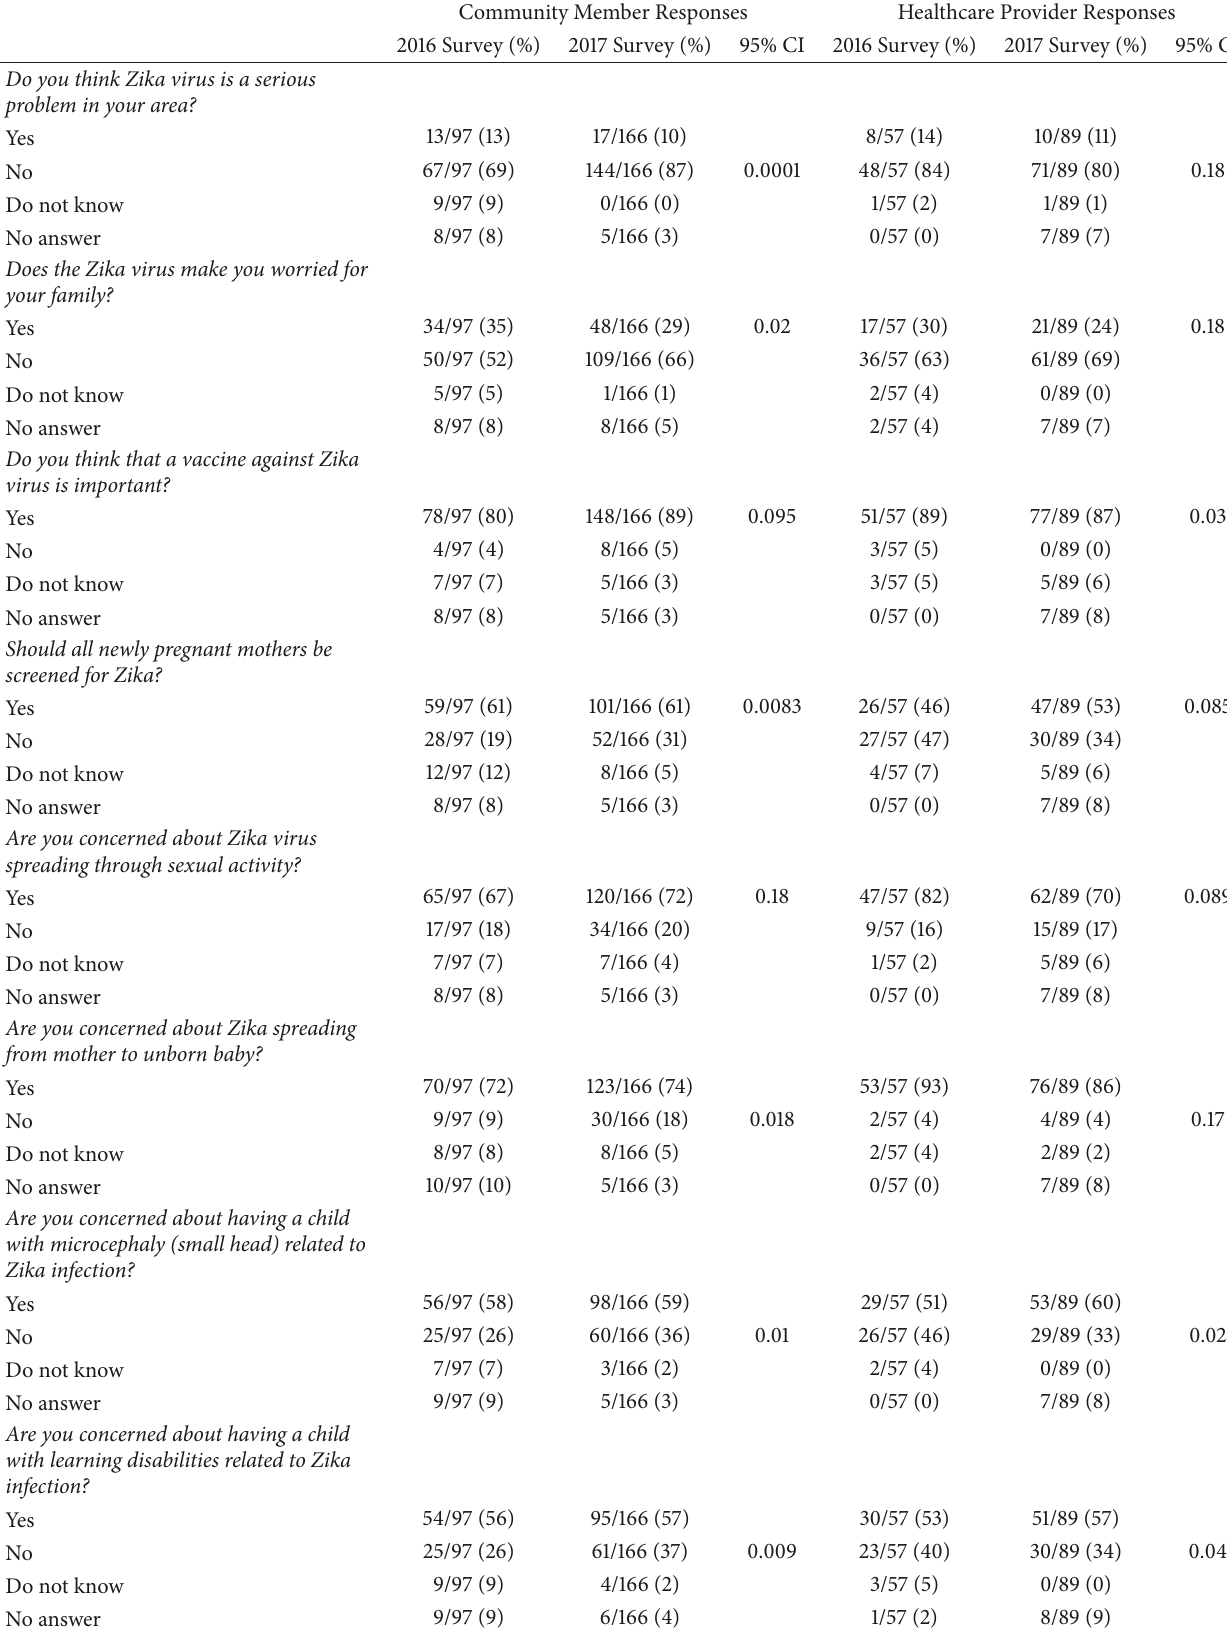
Table 3: Responses to “attitude” questions regarding Zika virus disease and